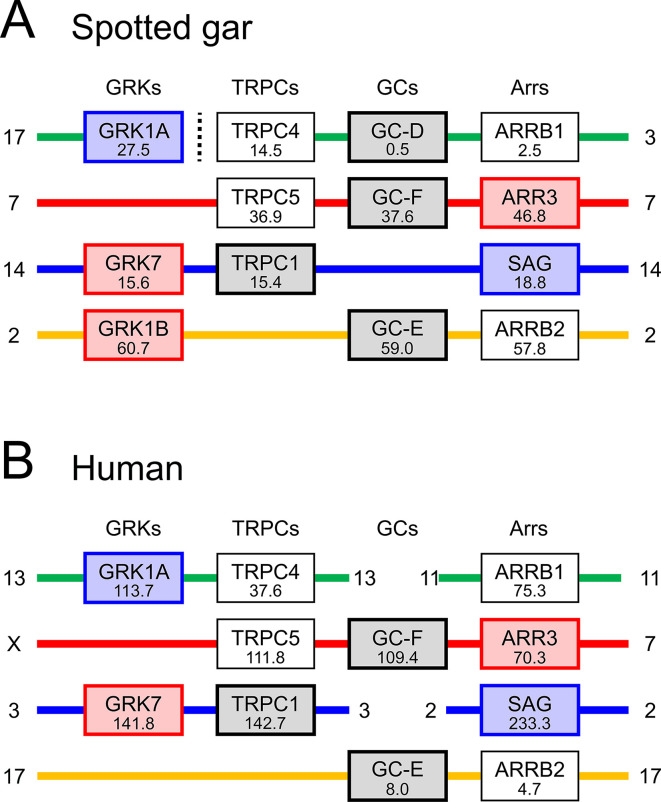
Summary of synteny for 4 gene families from 2 species.Gene locations are shown for TRPCs, visual GRKs, visual GCs, and arrestins. Number under each gene name represents the gene position in Mb on the indicated chromosome. Note that there is strong evidence that each interrupted row (where there is a break in continuity of a chromosome) corresponds to a contiguous set of genes in the ancestral quadruplicate genome. See S7 Fig for synteny across 11 gene families and 4 species. GC, guanylyl cyclase; GRK, G-protein receptor kinase; Mb, megabase; TRPC, transient receptor potential canonical.